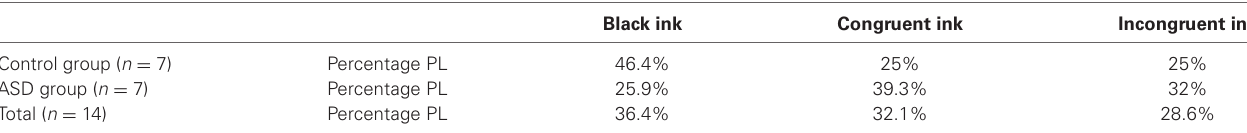
Table 2 | Presence of tail power law (PL) regimes in the distribution of the synchronization index during the Stroop color-word task